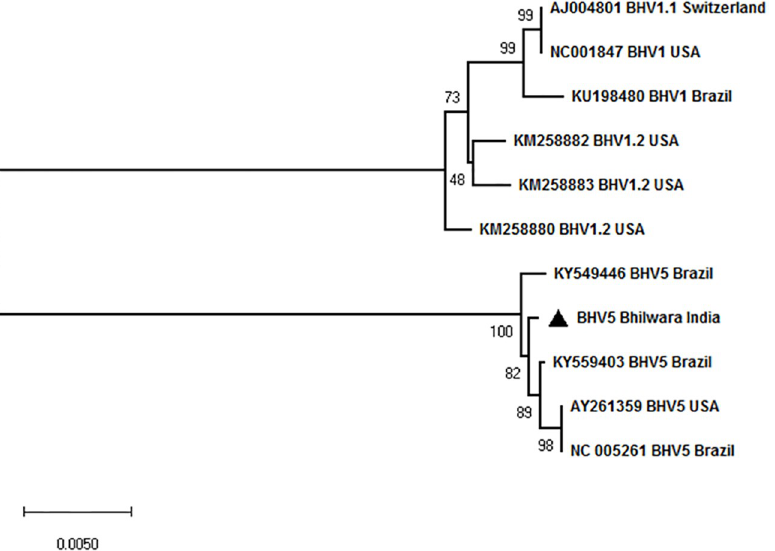
Fig 3. Phylogenetic analysis. Nucleotide sequences from UL27 , UL44 and UL54 genes (BoHV5//India/2018) were edited to 447, 1368 and 585 bp fragments respectively, using BioEdit version 7.0. These sequences, together with the representative nucleotide sequences of BoHV1 and BoHV5 available in the public domain (GenBank) were subjected for multiple sequence alignments. Phylogenetic analyses were conducted using MEGA X. To evaluate the evolutionary history of the strain as well as the phylogenetic relationship with different lineages, a concatemeric Neighbour-Joining method tree was generated. Test of phylogeny was performed using Maximum Composite Likelihood method and the confidence intervals were estimated by a bootstrap algorithm applying 1,000 iterations. The tree is drawn to scale, with branch lengths in the same units as those of the evolutionary distances used to infer the phylogenetic tree.